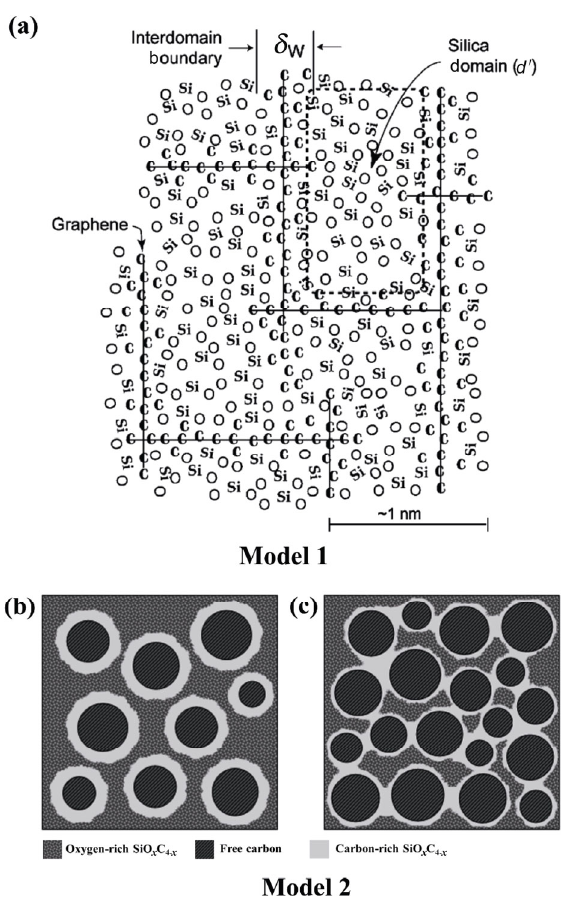
Fig. 3 Two proposed models illustrating the microstructure of polymer-derived SiOC ceramics: (a) a classic model illustrating a microstructure with clusters of silica tetrahedra, monolayer of SiC x O 4 − x mixed bonds and graphene cage-like network that encases the silica nanodomains; (b) Model 2 with isolated carbon-rich SiO x C 4 − x interface and (c) Model 2 with interconnected carbon-rich SiO x C 4 − x interface in carbon rich SiOC ceramics. Reproduced with permission from Ref. [36], © Elsevier Ltd.